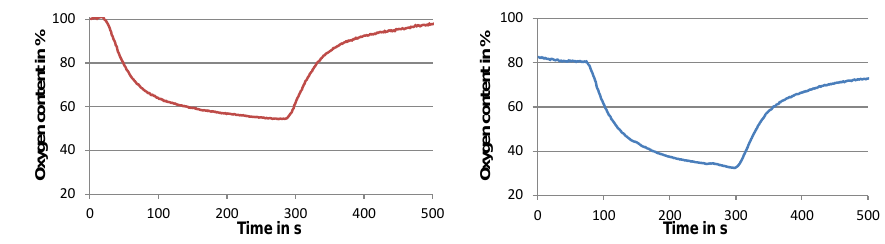
Figure 4. Deoxygenation–oxygenation curve measured at spot B for different pump gases (left: air, right: N 2